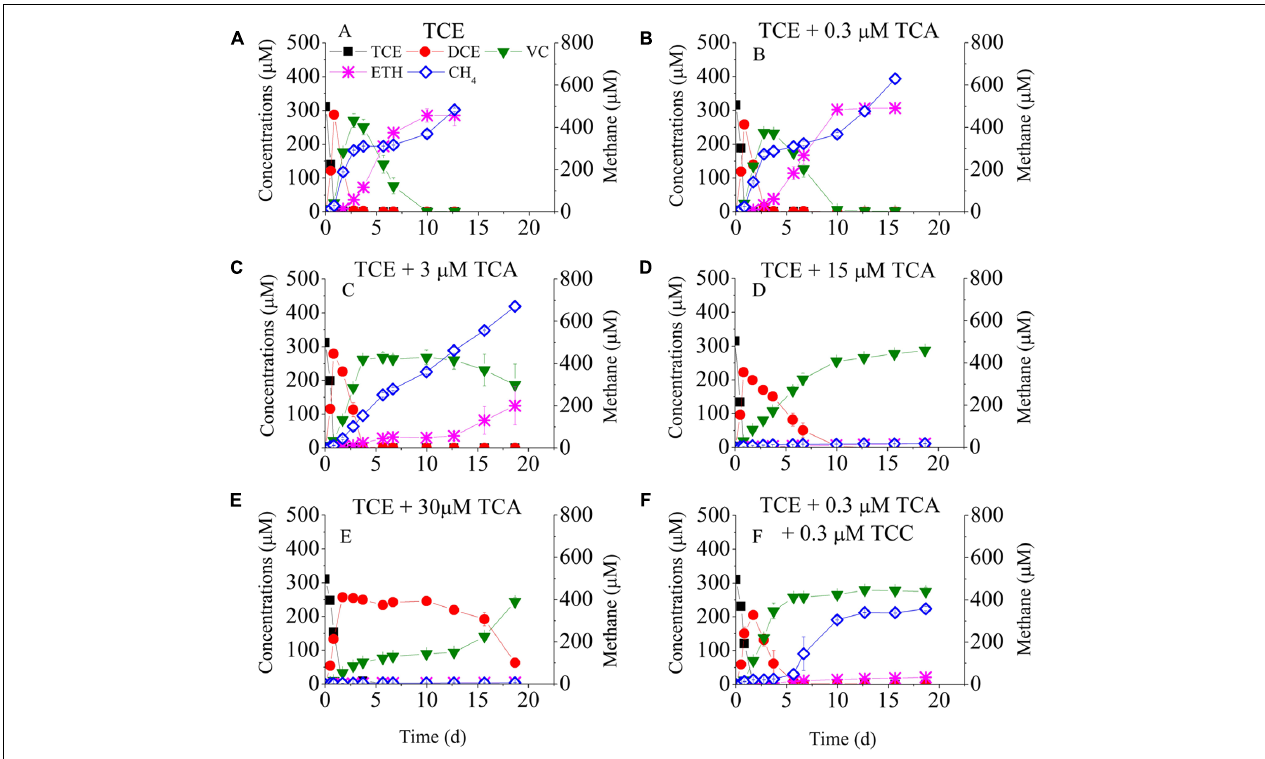
FIGURE 1 | Batch tests on the dechlorination of chlorinated ethenes in the cultures exposed to different concentrations of TCA. Left Y -axis is the concentrations of chlorinated ethenes and ethene. Batch test (A) TCE only; (B) TCE + 0.3 µ M TCA; (C) TCE + 3 µ M TCA; (D) TCE + 15 µ M TCA; (E) TCE + 30 µ M TCA; (F) TCE + 0.3 µ M TCA + 0.3 µ M